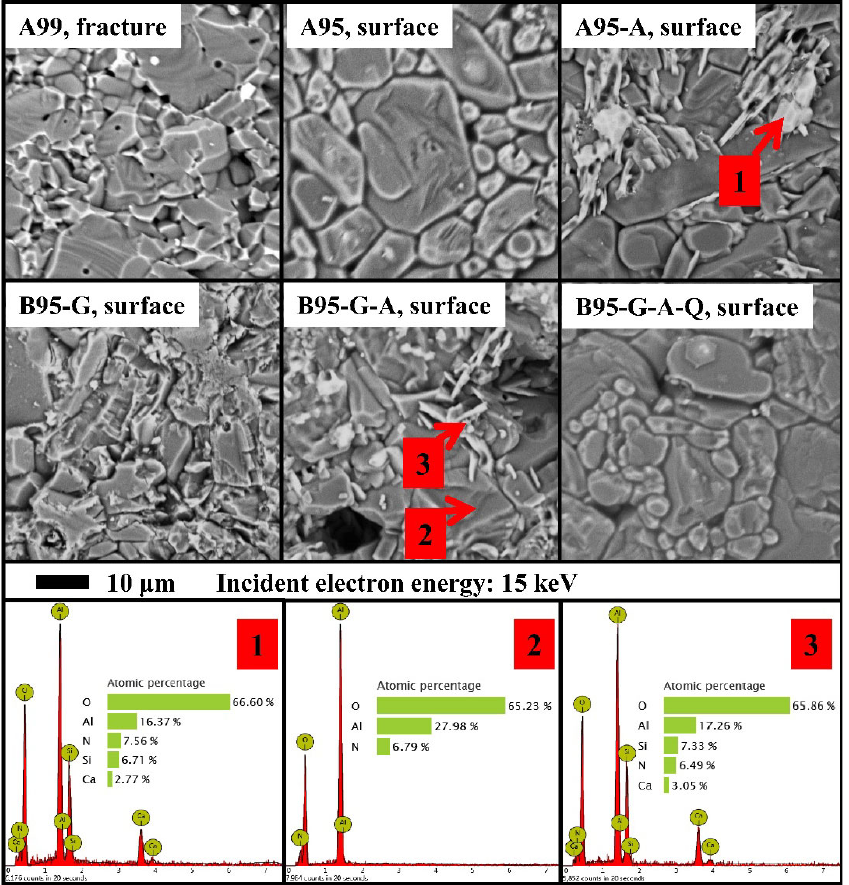
Fig. 4 SEM (back scattered electron) images: the chemical compositions at three points were analyzed by EDS.